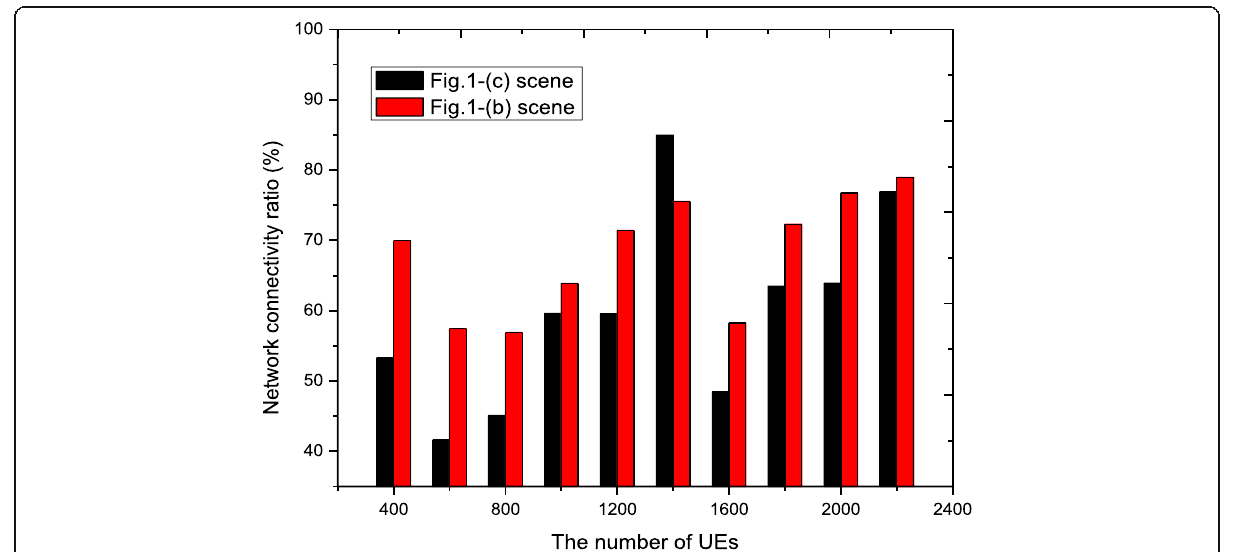
Fig. 21 Network connectivity ratio for the DTO-MROD scheme under the different scenes in Fig.